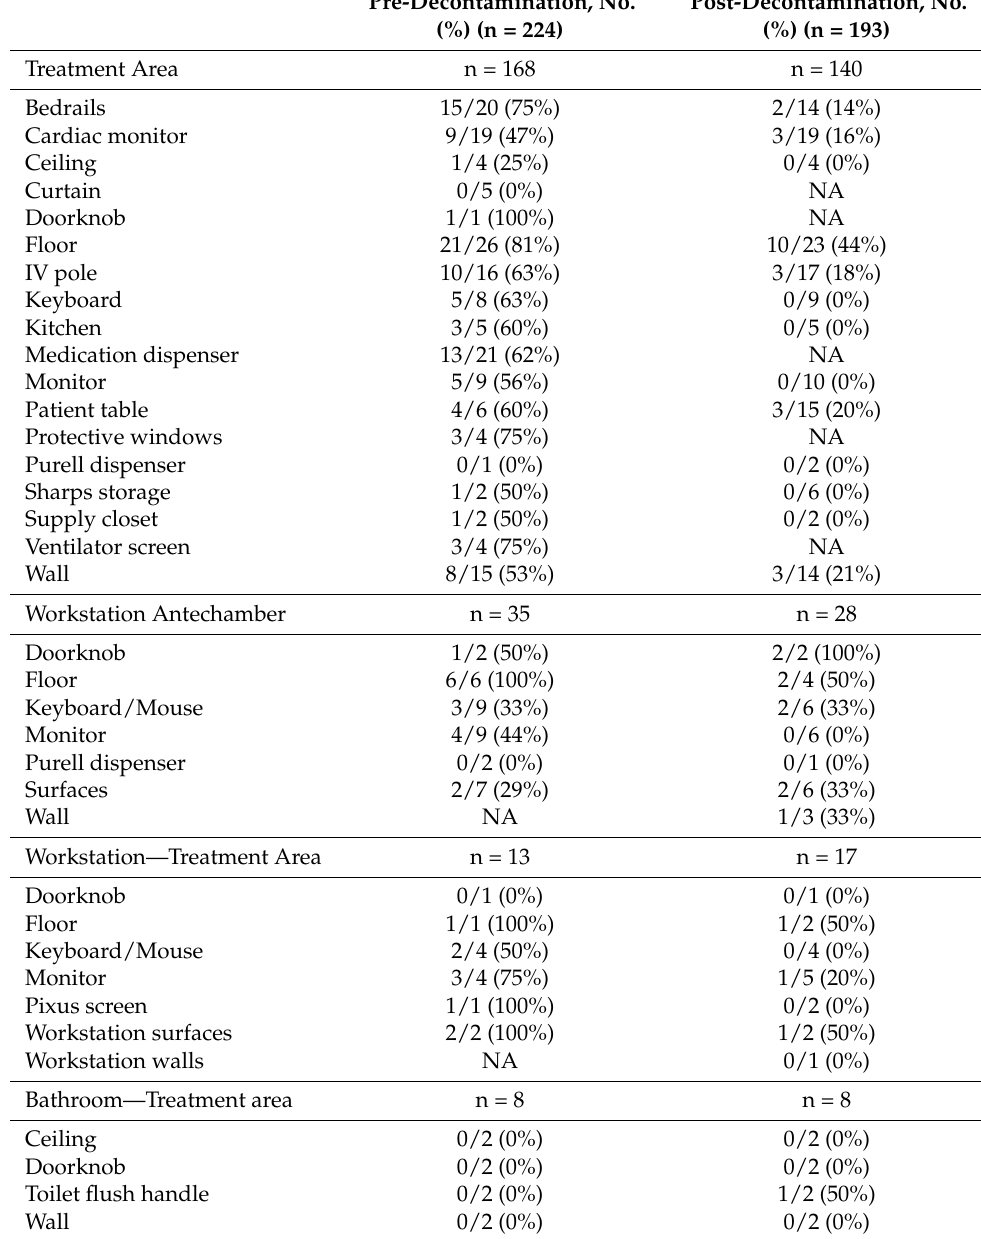
Table 1. Viral Distribution of Objects Positive for SARS-CoV-2 Pre- and Post-Decontamination. Pre-Decontamination,